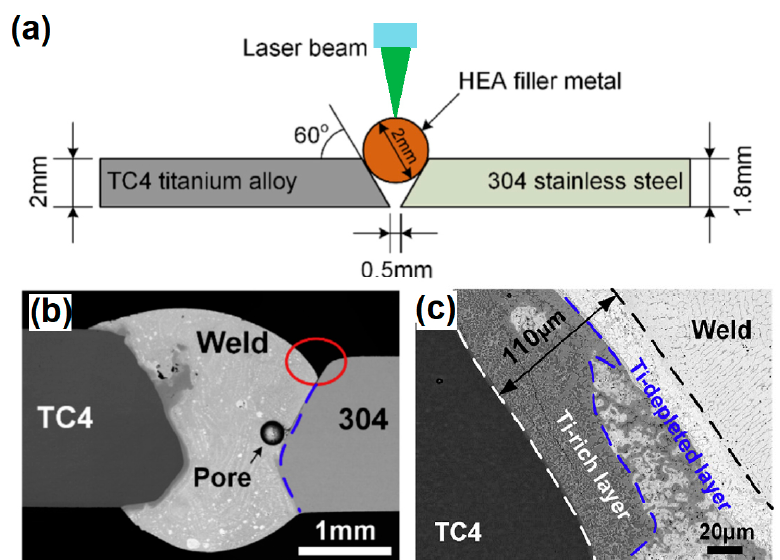
Figure 10. ( a ) Schematic illustration of dissimilar welding between TC4 Ti alloy and 304 stainless steel using a HEA as filler metal, ( b ) welding macroscopic aspect, and ( c ) layer formed between the WZ and the TC4 titanium. Adapted from [39].